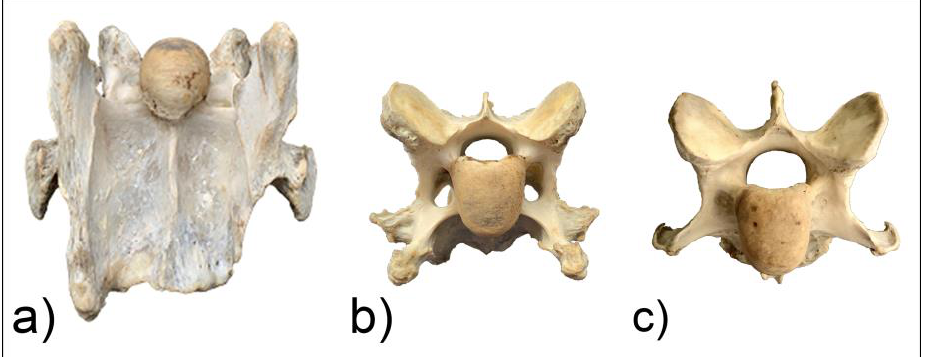
Figure 6. The ventral aspect of C6 ( a ) and cranial views of C6 ( b ) and C7 ( c ) of horse